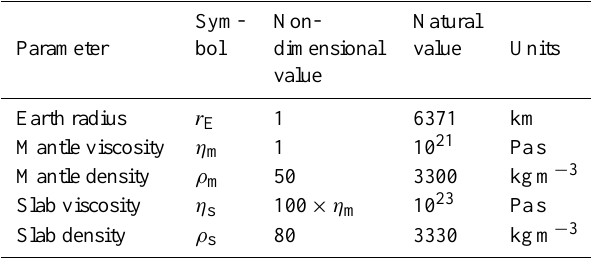
Table 1. Reference model